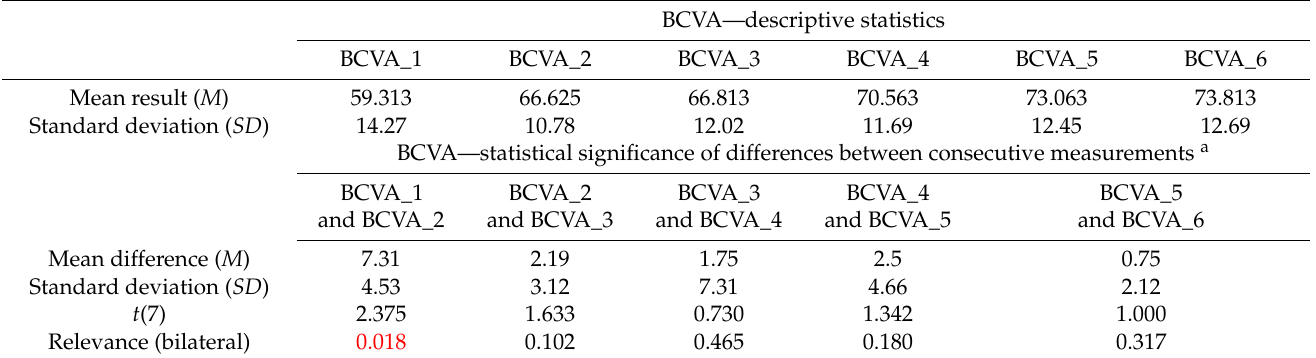
Table 2. BCVA—Descriptive statistics and statistical significance of differences.